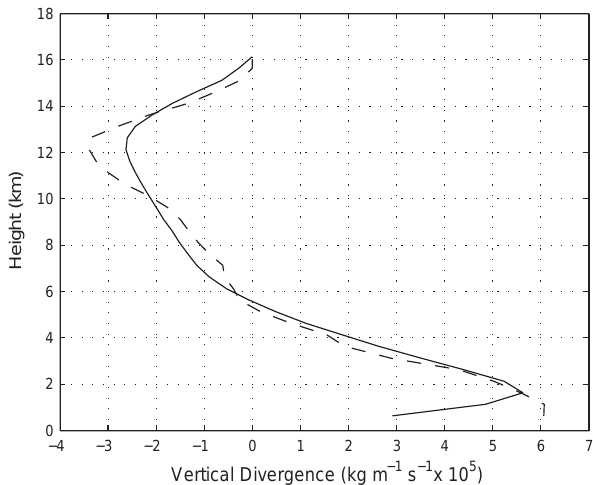
Fig. 2. Horizontally-integrated vertical divergence for the 29 June 2000 supercell case at 23:57UTC (dashed line) and averaged over all times (solid line). The level of maximum detrainment (LMD) is 12.1km for the 23:57UTC divergence line, and 12.3km for the time-averaged divergence